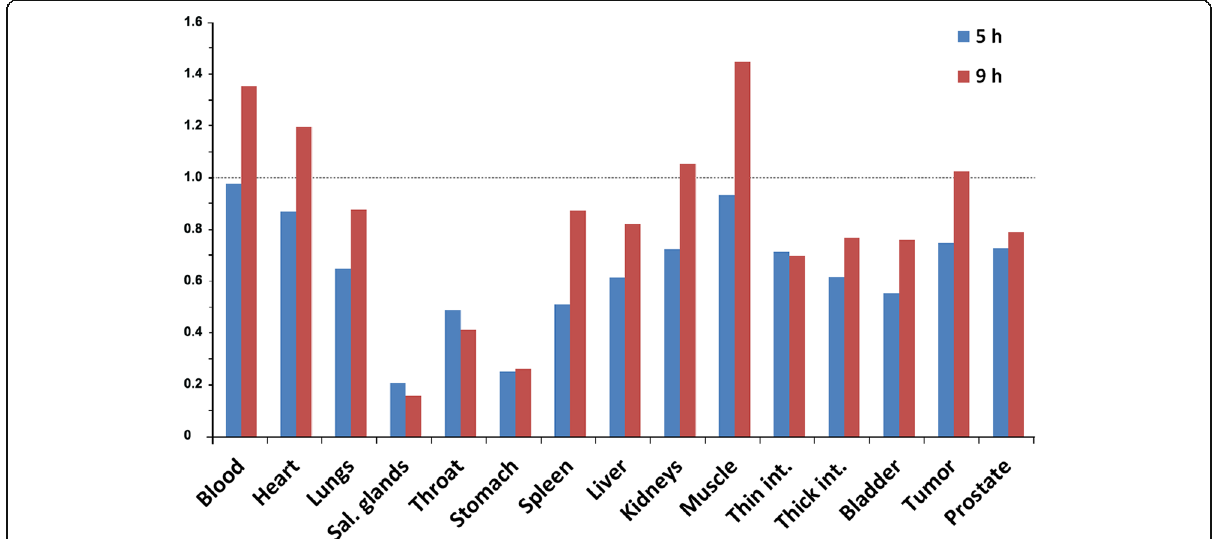
Fig. 3 The relative effect of pre-treatment with sodium perchlorate (2.5 mg NaClO 4 ·H 2 0) on the biodistribution of 211 At-A11 minibody. For each organ. the %IA/g-value received with pre-treatment was divided with the %IA/g-value without pre-treatment, respectively for the two time points